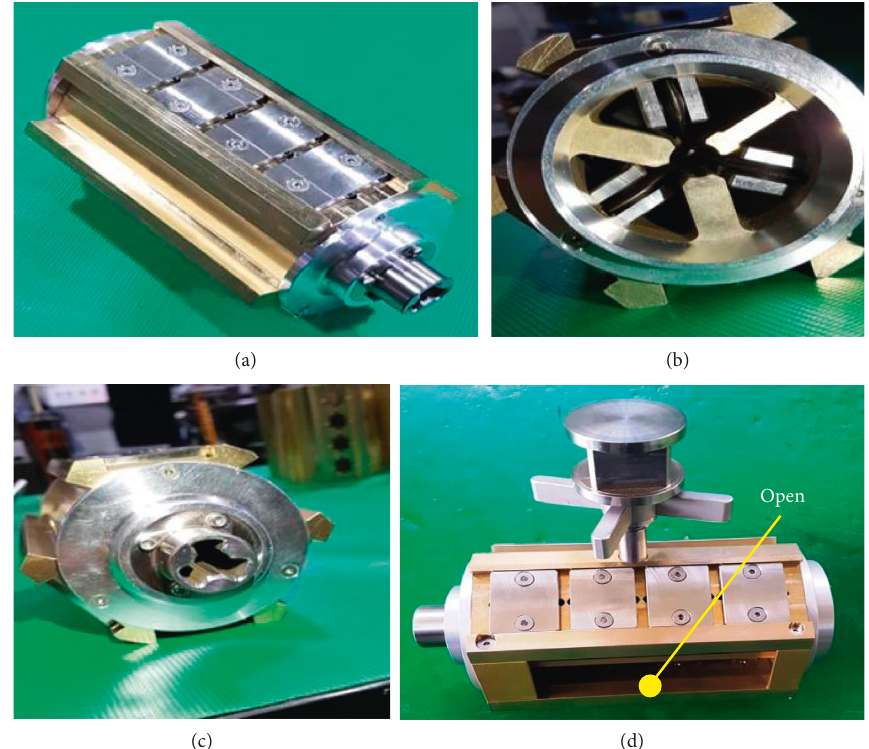
Figure 19: Newly developed 3-CUT blade module and loading unit: (a) front view, (b) left view, (c) right view, and (d) loading